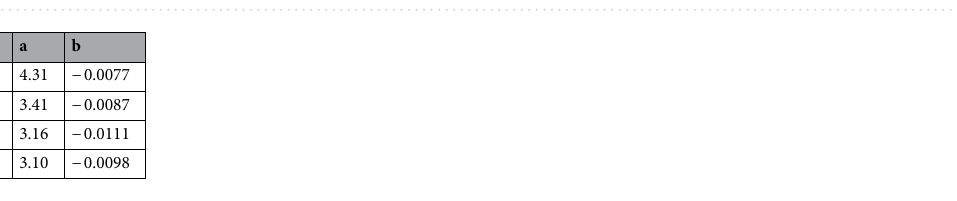
Table 1. Parameters of power-law least square fits applied to Fig. 6a